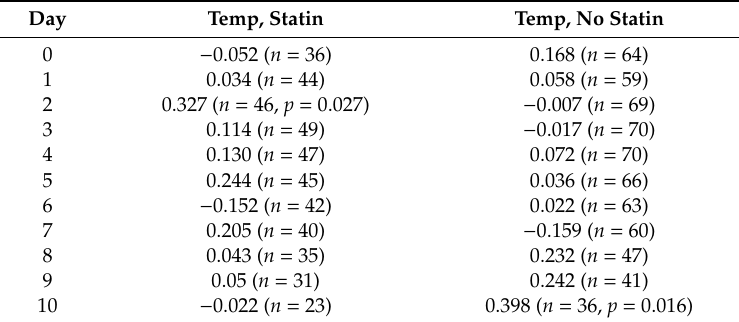
Linear regression analysis of preoperative CRP values versus postoperative CRP, leukocyte number (leuko) and body temperature (temp). The correlation coefficients ( r ) as well as n -numbers and p -values ( ≤ 0.05) are given.